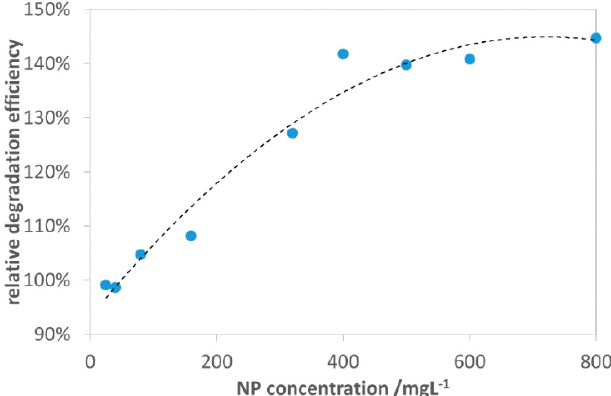
Figure 10. Effect of NP-3 (x = 0.4) concentration on the relative efficiency of degradation (compared to the photodegradation of MB without catalysts). Concentrations: MB = 1.5 × 10 − 5 mol/L, conc. of H 2 O 2 = 1.01 × 10 − 2 mol/L, and initial pH = 7.5.